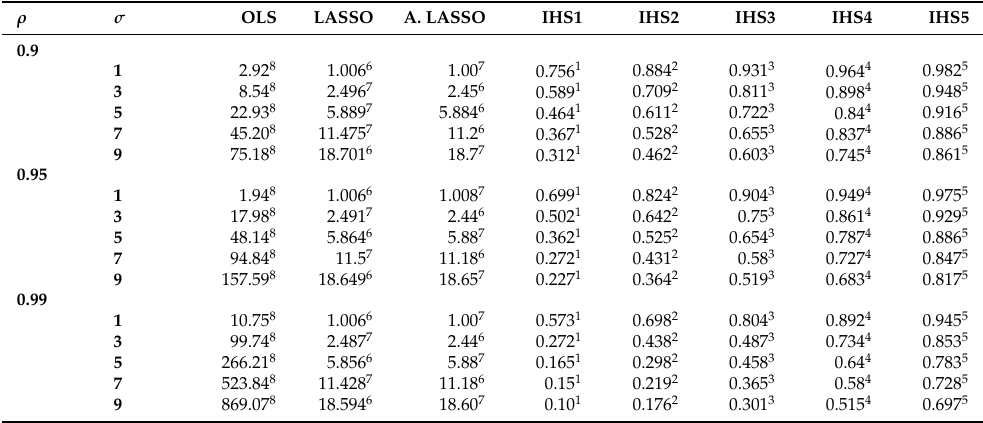
Table 9. Estimated MSEs for n = 150 and p = 16 (superscript represents